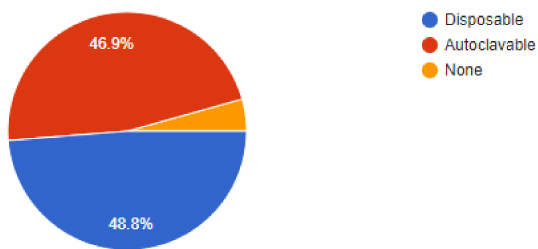
Figure 14. Have you added more instruments? If so, are they disposable or autoclavable?